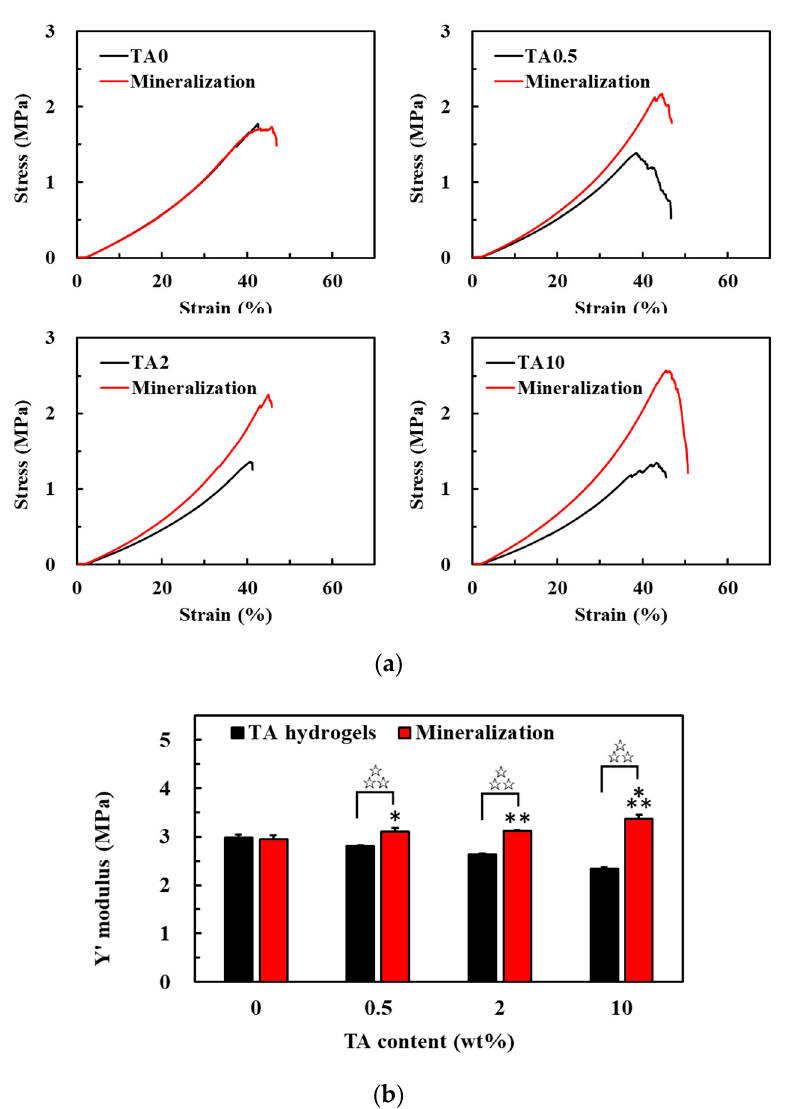
Figure 6. Mechanical properties of the TA-supplemented nanocomposite hydrogels. ( a ) The stress– strain curves for the TA-supplemented nanocomposite hydrogels before and after mineralization. ( b ) Young’s moduli of the TA-supplemented nanocomposite hydrogels before and after mineraliza- tion. Value = mean ± standard deviation, n = 4. *: p < 0.05 vs TA0 (mineralization); **: p < 0.01 vs TA0 (mineralization); ***: p < 0.001 vs TA0 (mineralization); ☆ ☆☆ : p < 0.001.